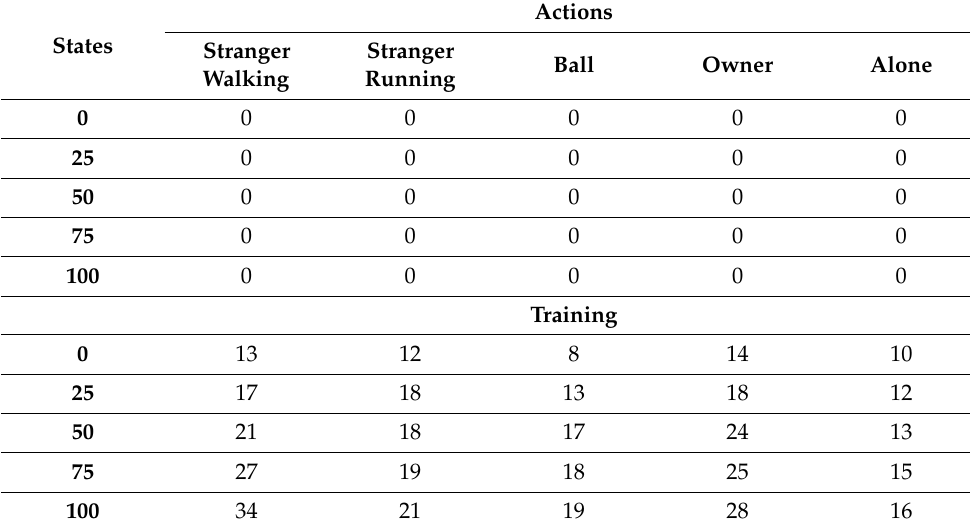
Table 3. Q–learning during different states of